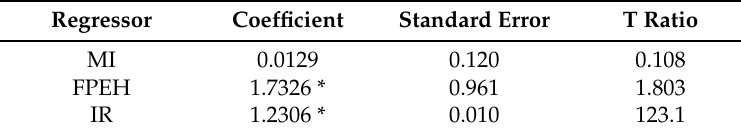
Table 6. Estimated long run coefficients for selected ARDL model.